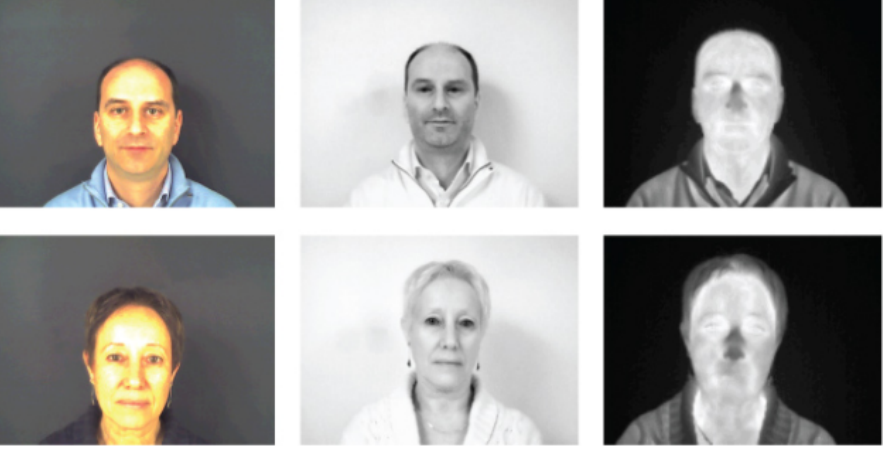
Figure 4. Example images from Carl dataset